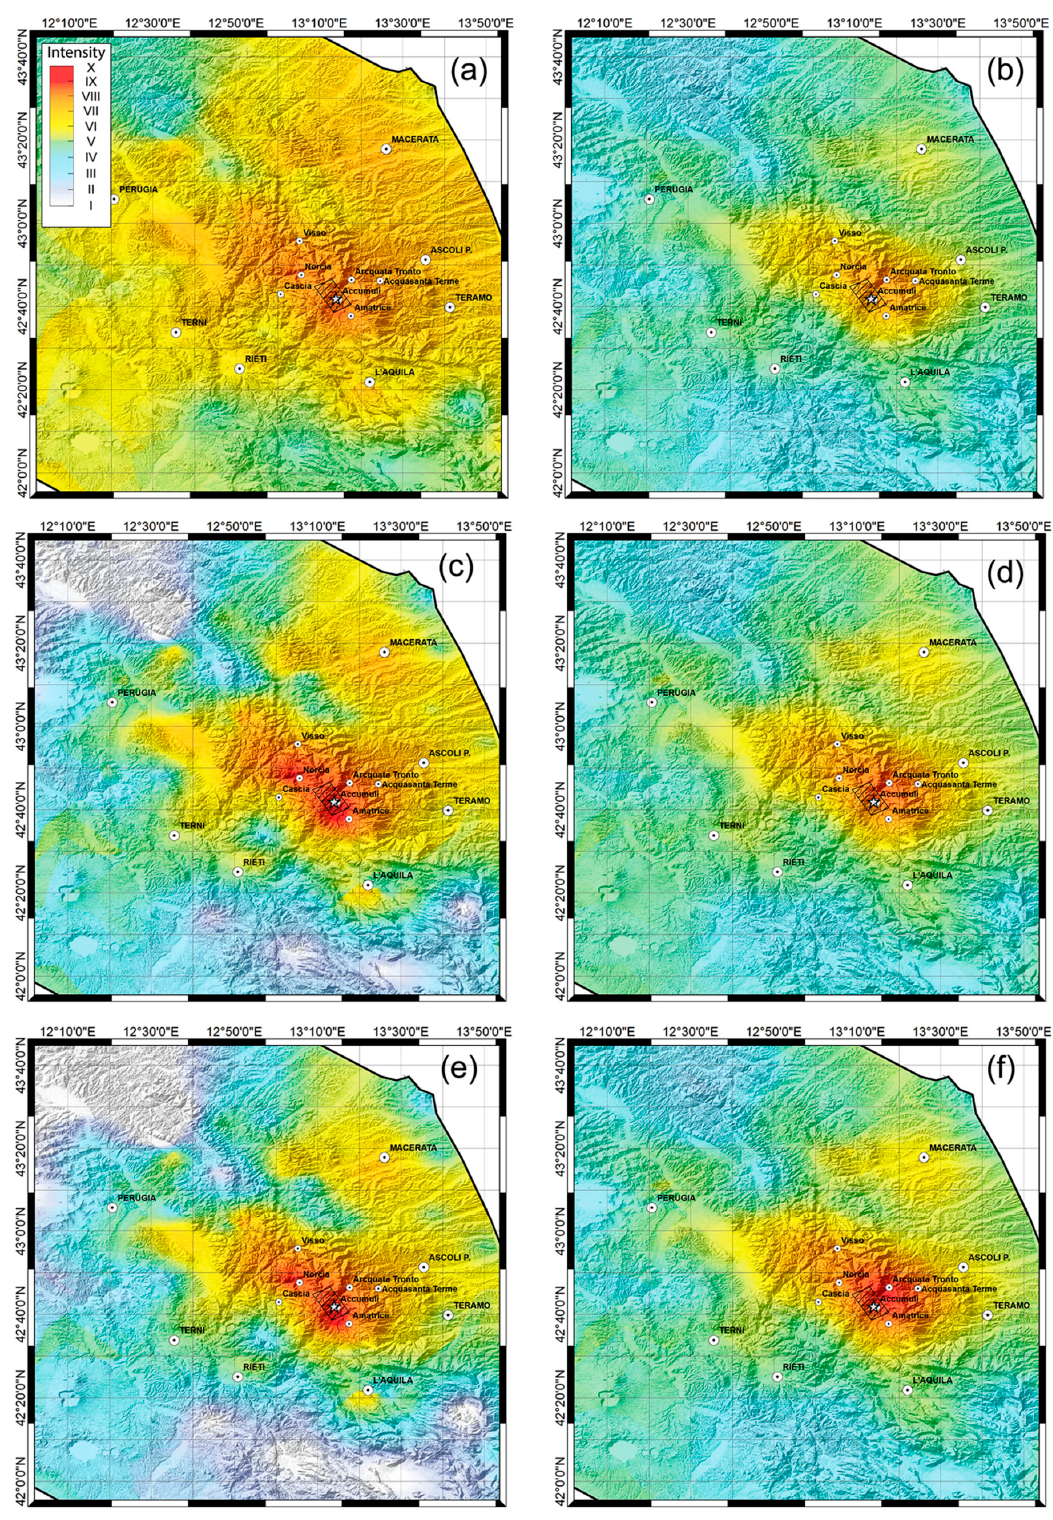
Figure 8. Intensity maps for the M W 6.0 Amatrice earthquake based on cumulative absolute velocity ( a , c , e ) and Arias intensity ( b , d , f ). The maps were obtained by three different relationships: Cabanas et al. [27] ( a , b ), Koliopulos et al. [28] ( c , d ), and Tselentis and Danciu (2008) [29] ( e,f ).